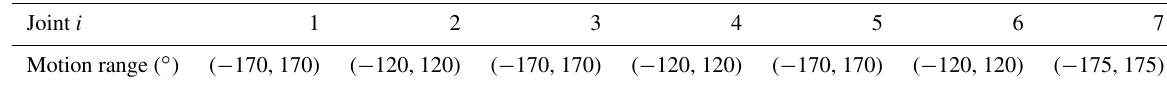
Table 5. The joint motion ranges of the manipulator.